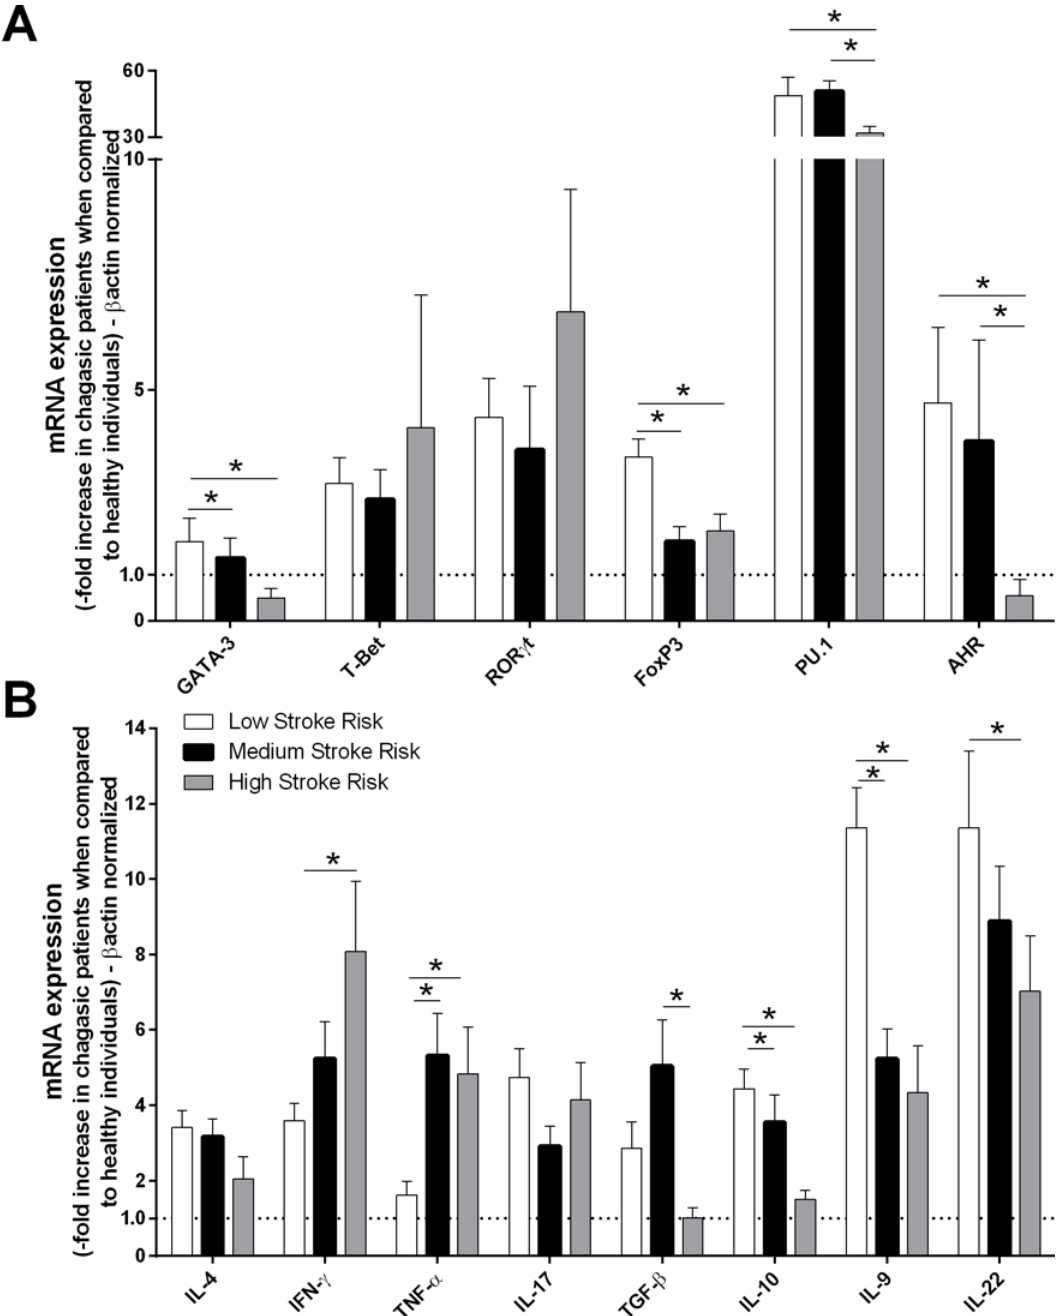
Fig 3. Patients who exhibited low stroke risk also exhibited high GATA-3, Foxp3, PU.1, AHR, IL-9, IL-22 and IL-10 expression. The mRNA expression levels of transcription factors (A) and cytokines (B) were determined by real-time PCR in peripheral blood mononuclear cells of chagasic patients with low (n = 40), medium (n = 18) and high (n = 7) risks of stroke. The expression levels were normalized to the expression level of β -actin . The results are expressed as the means ± standard errors. * P <